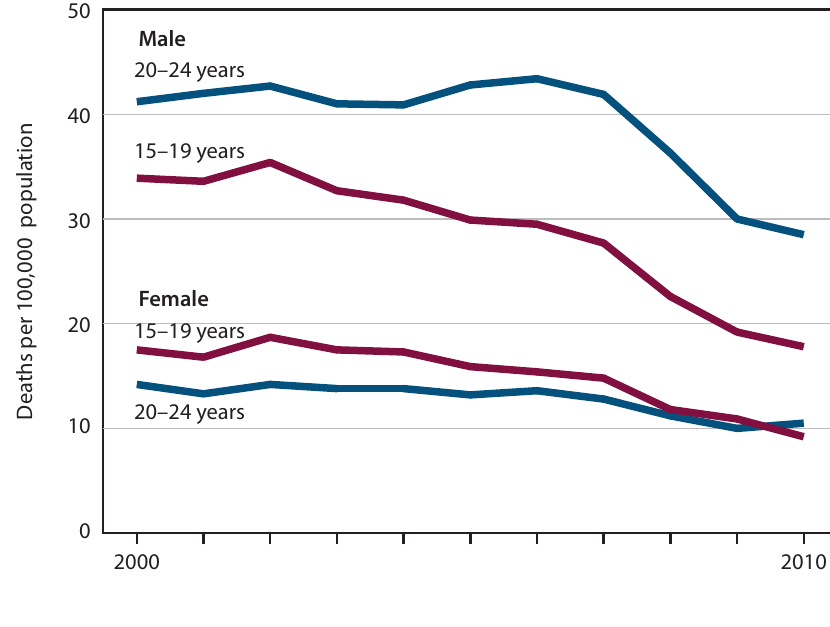
Figure 4. Motor vehicle-related death rates among persons aged 15–24, by sex death rates declined among males and females and age: United States, 2000 –2010 aged 15–19 and